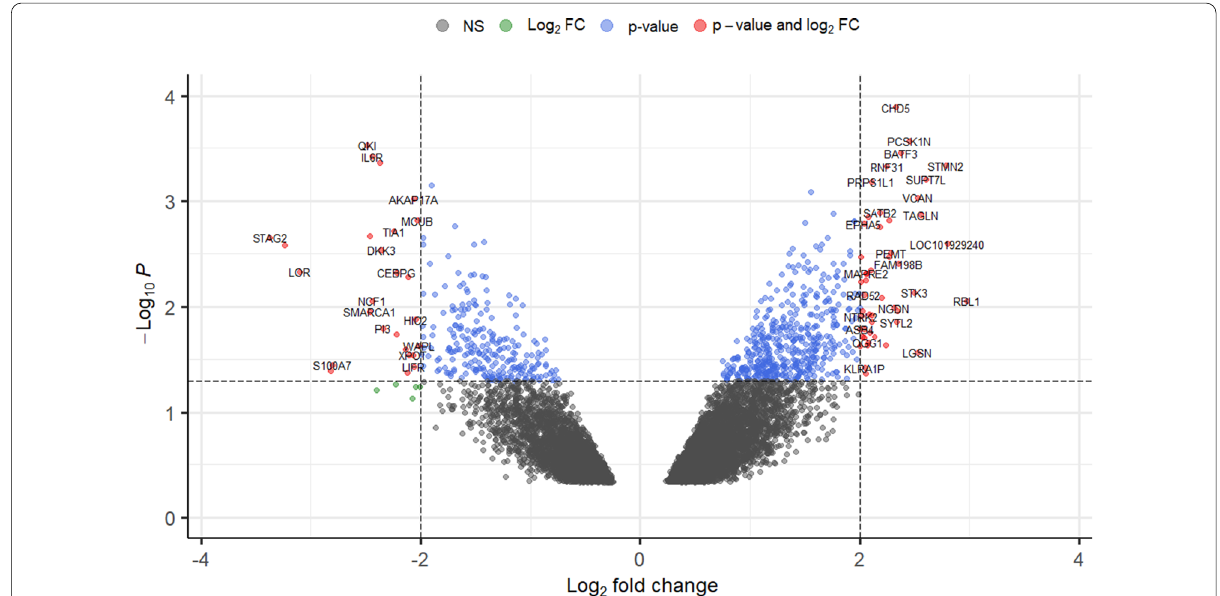
Fig. 1 Volcano plot of the most significantly differentially expressed genes in smoker buccal mucosa. Gray points are non‑significant, green points have a significant log2FC, blue points have a significant p value, and red points have both a significant log2FC and p value